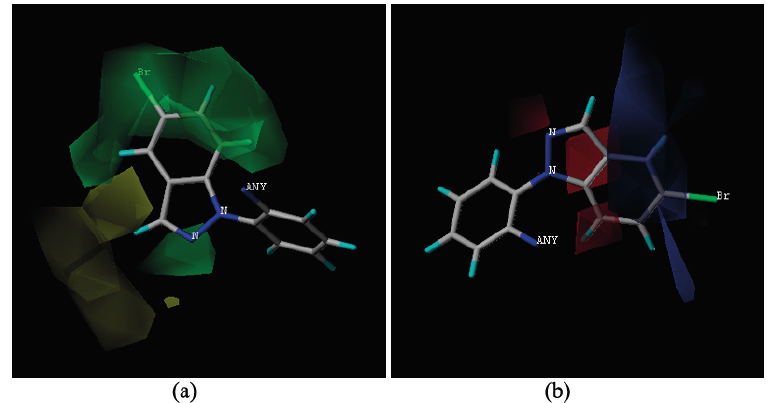
Figure 2. Topomer CoMFA contour maps around the amine moiety. ( a ) steric field around